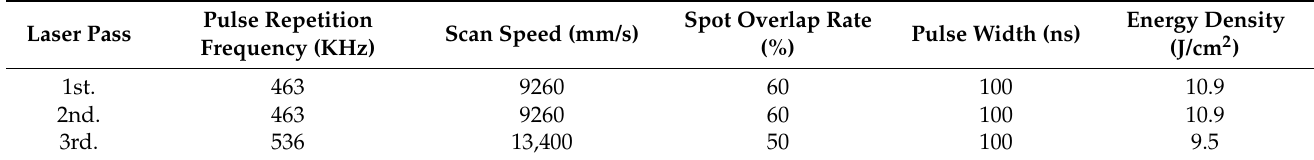
Table 3. Laser processing parameters.